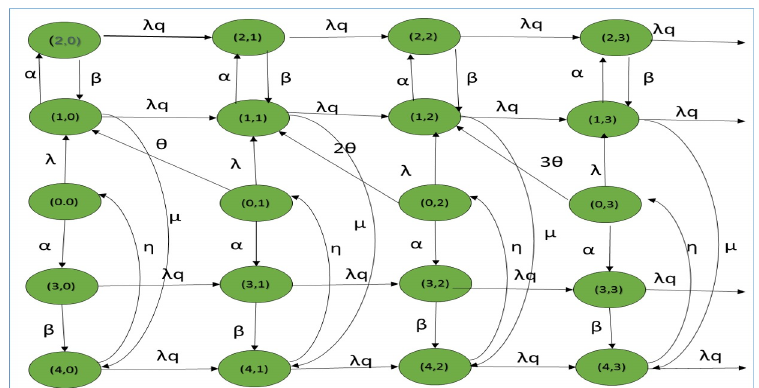
Figure 2. State-transition